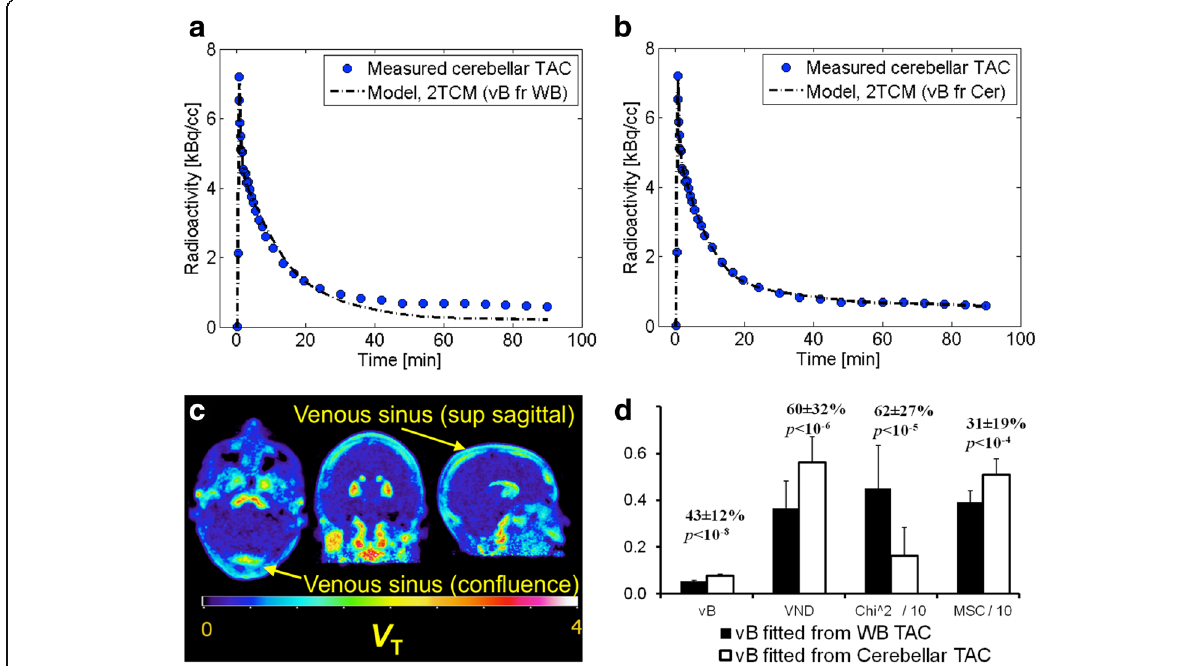
Fig. 1 a Fit of the 2TCM to the [ 18 F]MNI-659 cerebellar TAC using vB obtained from fitting the whole brain TAC, and b corresponding fit with vB fitted with the rate constants. The improved fit may be related to the high signal from blood vessels, seen in the parametric image shown in c . Fitting vB with the rate constants results in higher vB , higher V Χ 2 , and higher model selection criteria, shown in d . The numbers above the bars in d ND , lower displays the percentage difference and the p -value from a paired t-test between the estimates obtained from the two procedures to fit